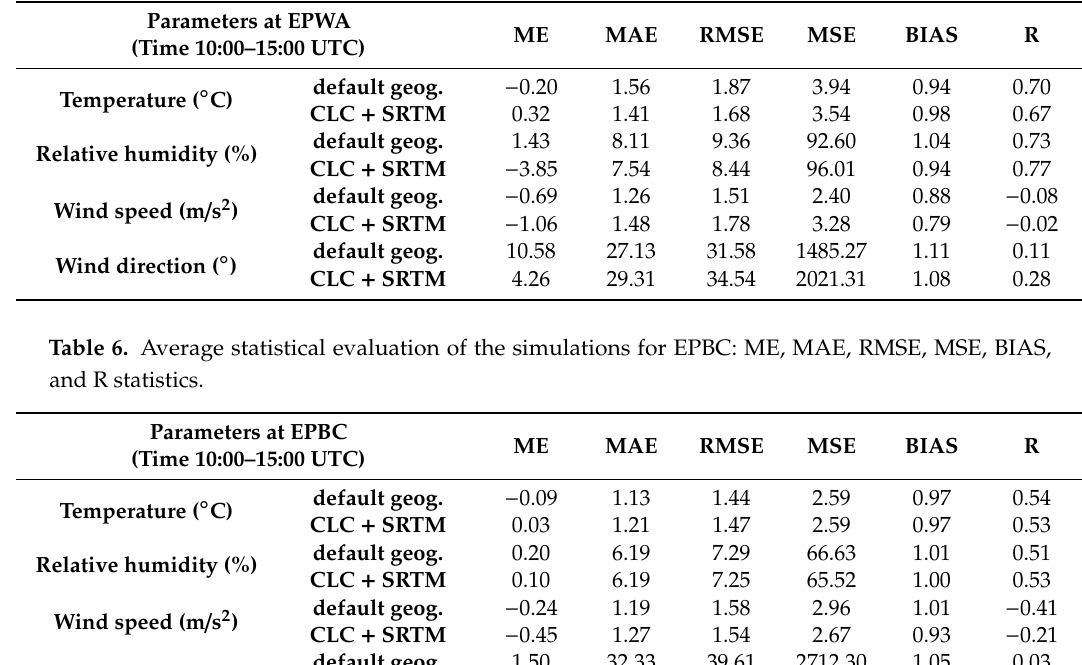
Table 5. Average statistical evaluation of the simulations for EPWA: ME, MAE, RMSE, MSE, BIAS, 379 and R statistics. 380